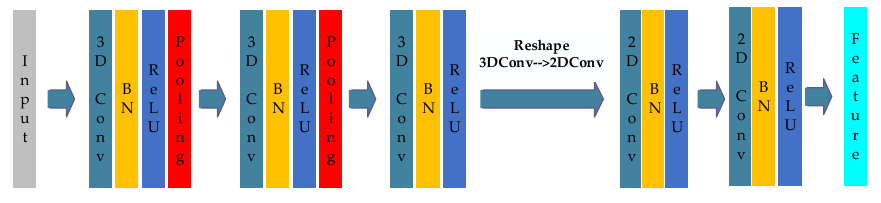
Figure 8. Feature